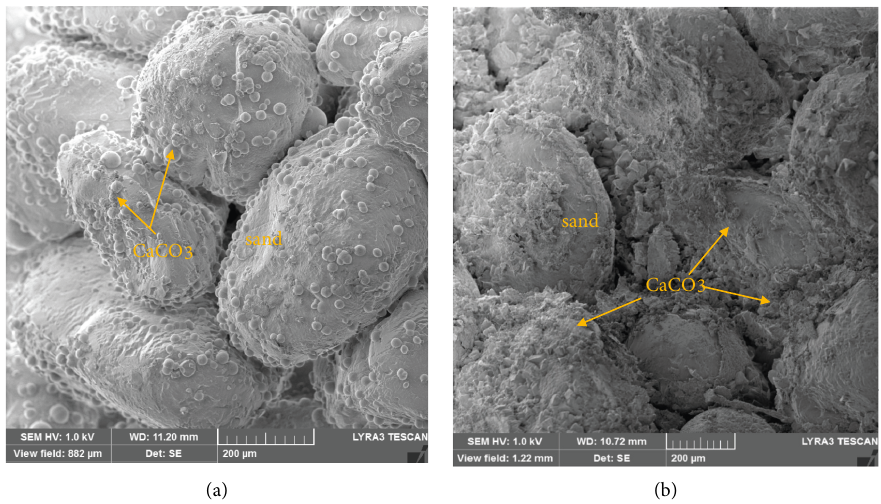
Figure 9: SEM images of (a) 0.25M Ca and (b) 0.5 M Ca MICP-treated